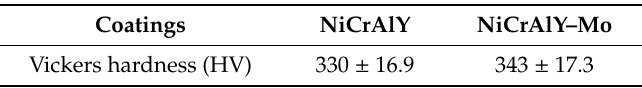
Table 3. Microhardness of coatings.